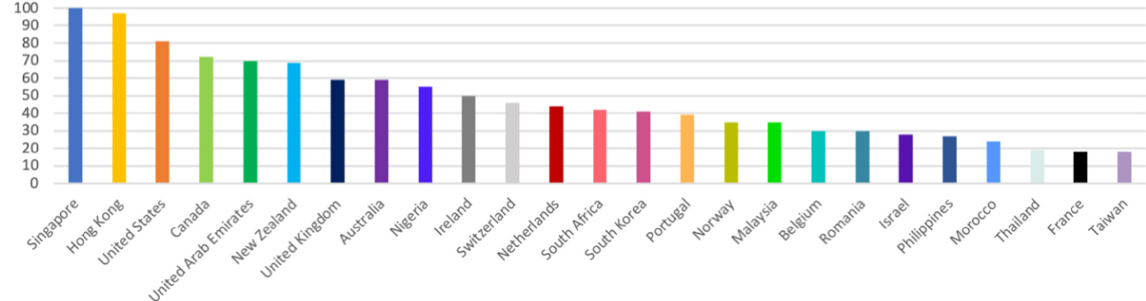
Figure 5. Google search for “NFT Music” by country.